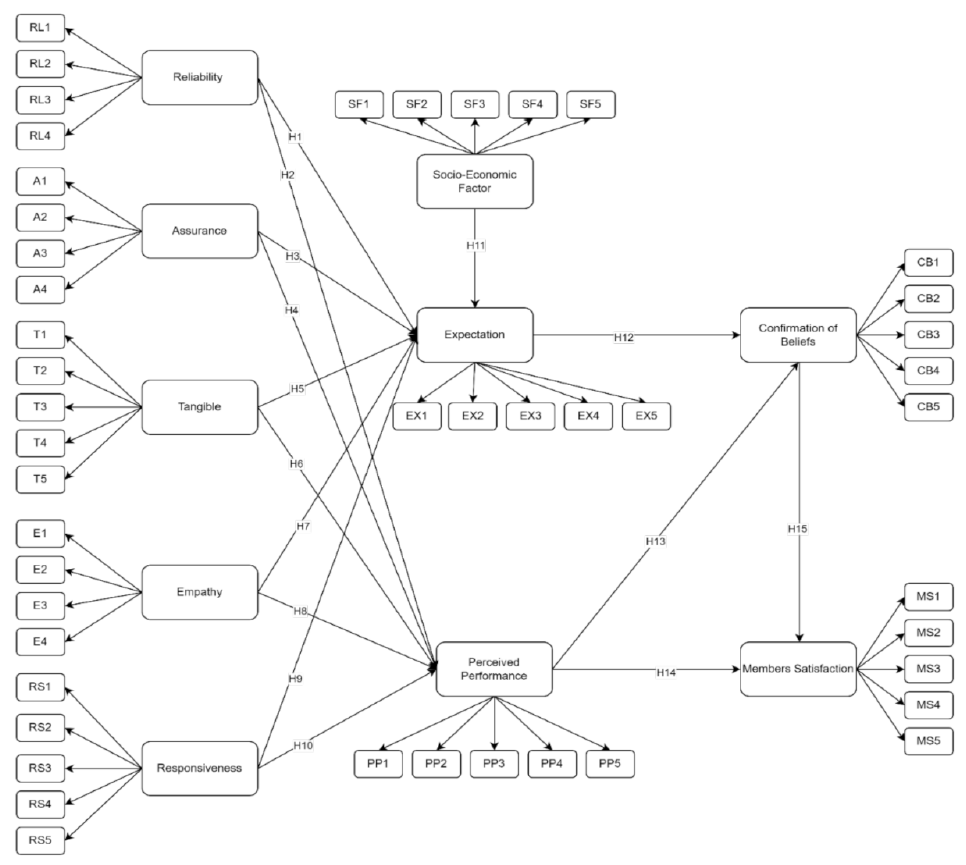
Figure 3. SEM Model